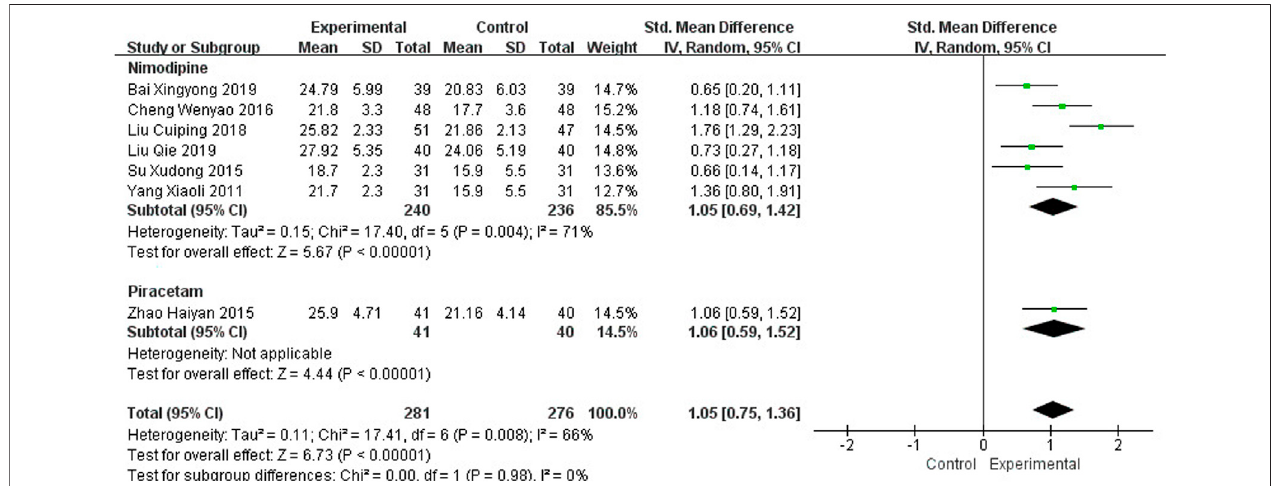
FIGURE 3 | Meta-analysis of MoCA by NBP as monotherapy.